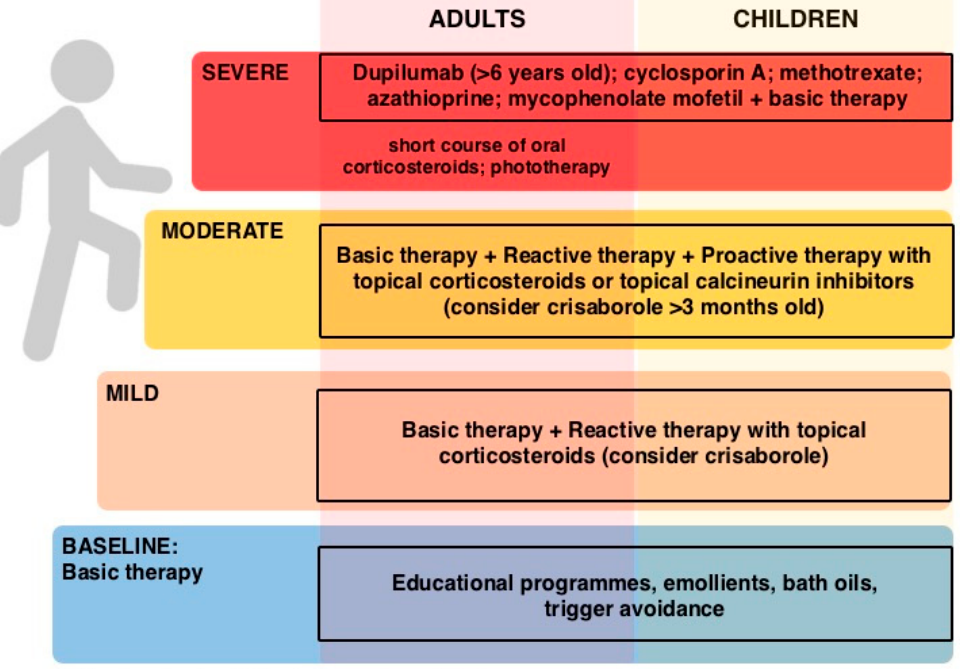
Figure 1. Atopic dermatitis therapeutic stepwise approach adapted from